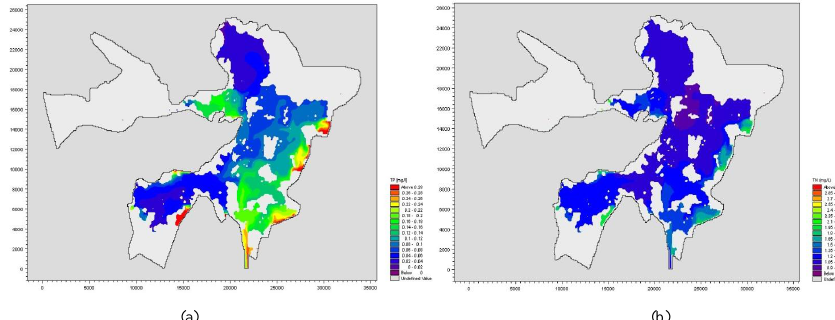
Fig. 19. The spatial variations of concentrations of TP (a) and TN (b) Figure 19. Spatial variations in concentrations of TP (a) and TN (b) . Fig. 21. Simulation results of the main ecological indexes at zone II Table 8. Simulation results of the key water ecological indexes for the four water area zones were shown in Fig. 20-Fig. 23. Table 8. Water ecological indexes of water area zones Fig. 21. Simulation results of the main ecological indexes at zone II